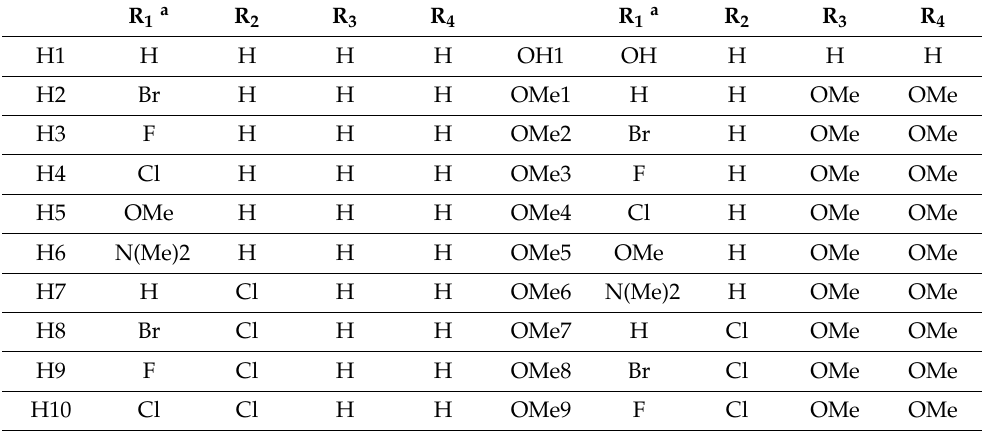
Figure 13. Ranking of the 23 enol- (blue triangles) and 23 diketo (red diamonds)-forms according to their calculated prostate cancer treatment (PCT) ability. H1,H2 etc. refer to Table 4. For comparison, the values for the enol-form (eC1) and the diketo-form (kC1) of curcumin is included. Taken from [42]. Table 4. Substitution patterns for the curcumin analogues.